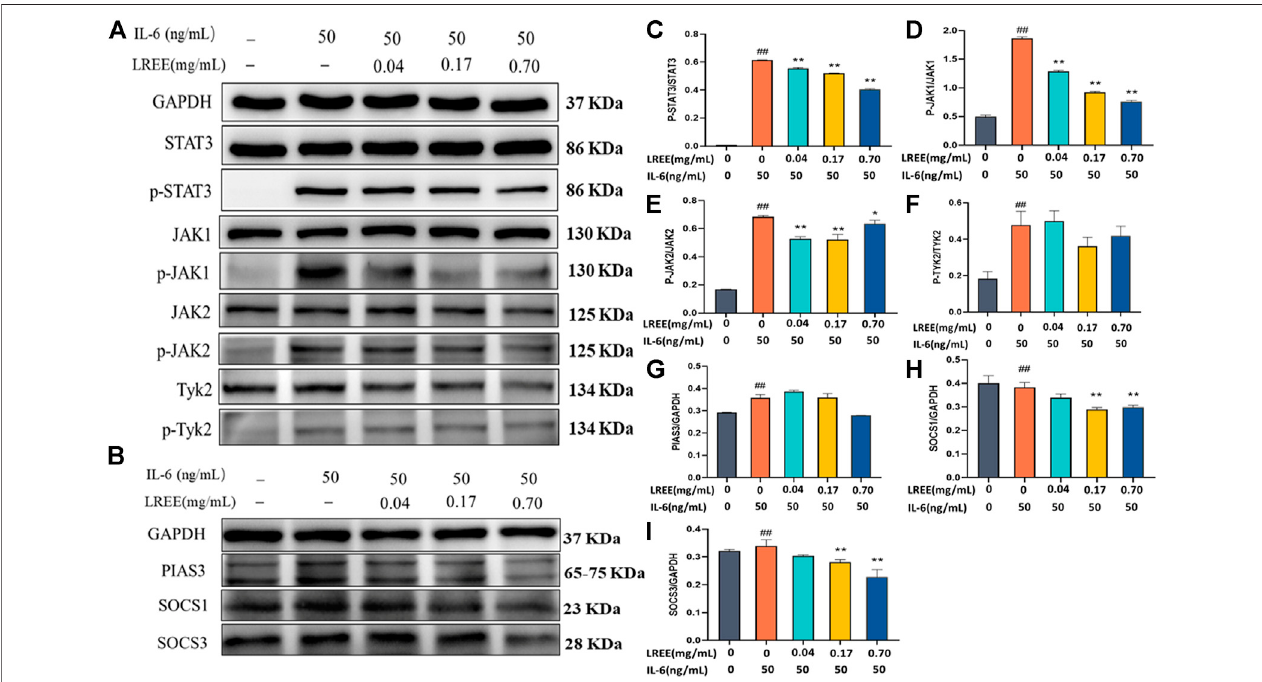
FIGURE 8 | Expression of the proteins related to IL-6 signaling pathway in lymphocytes in vitro ( n (cid:2) 3). (A) WB analysis of STAT3, phospho-STAT3, JAK1, phospho-JAK1, JAK2, phospho-JAK2, Tyk2, and phospho-Tyk2 in lymphocytes after the intervention of LREE. (B) WB analysis of PIAS3, SOCS1, and SOCS3 in lymphocytes after the interventionof LREE. (C – F) Densitometry analysis ofphosphorylated STAT3, JAK1, JAK2and Tyk-2 levels. (G – I) Densitometry analysis ofPIAS3, SOCS1, and SOCS3 levels. # P ＜ 0.05, ## P ＜ 0.01 vs. blank control (none-LREE or IL-6-treated) group. * P ＜ 0.05, ** P ＜ 0.01 vs. IL-6 group.